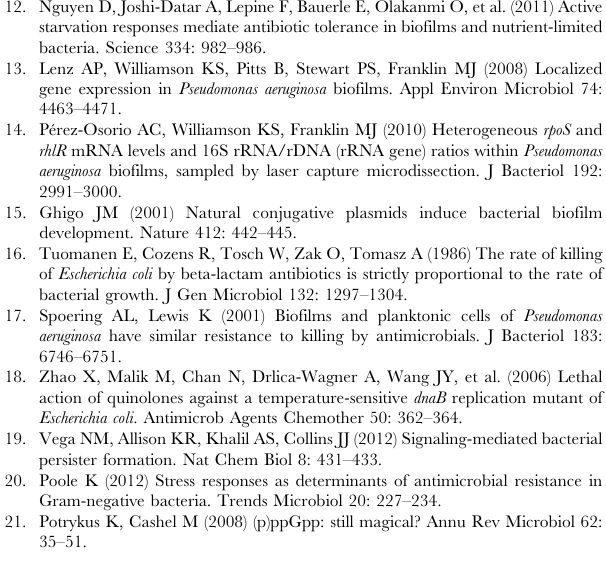
Figure S5 The impact of starvation on translation efficiency.